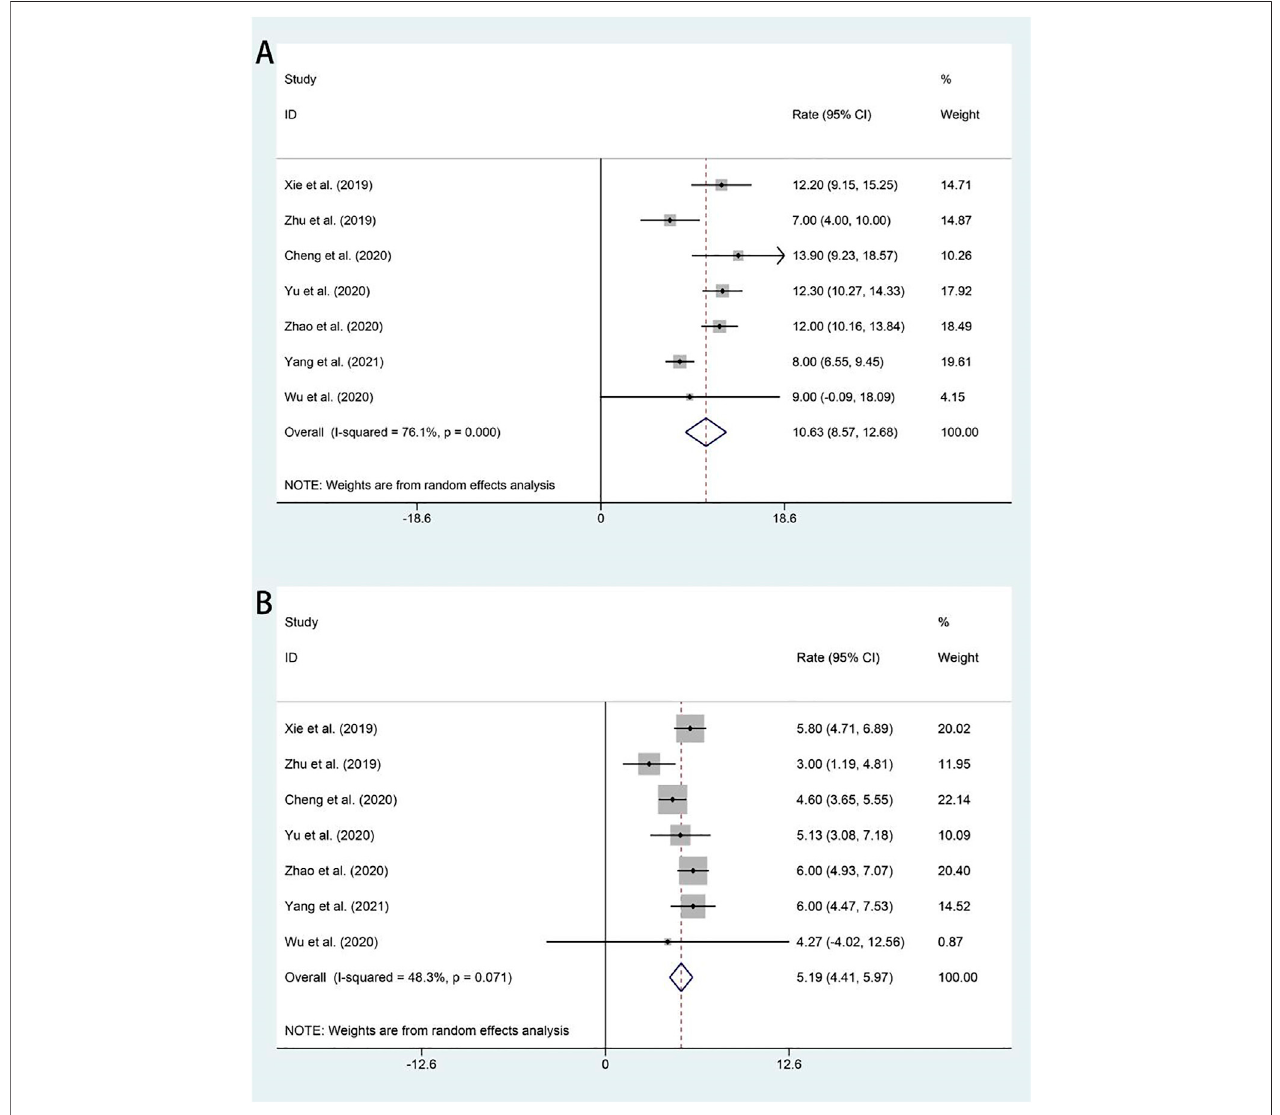
FIGURE 3 | Forest plot about the pooled results of OS (A) and PFS (B) in total by the treatment regimen. OS, overall survival; PFS, progression-free survival.